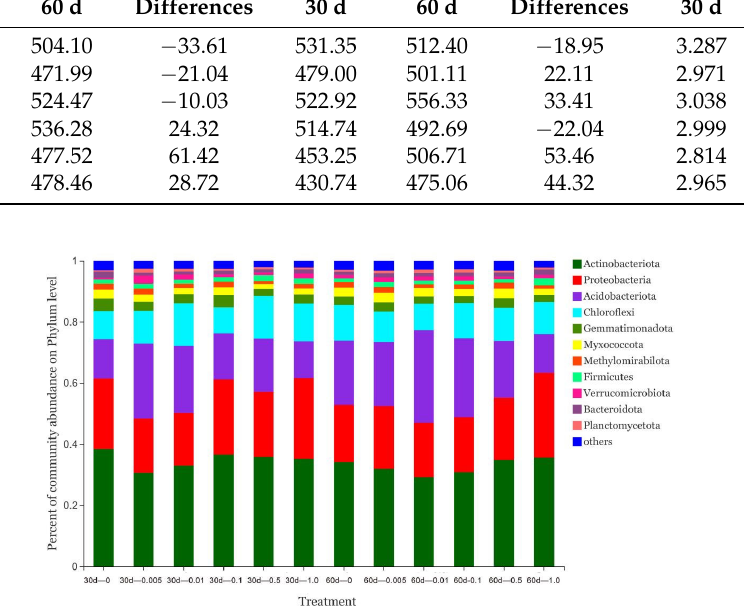
Figure 5. Effect of pyrogallic acid on bacterial community composition.